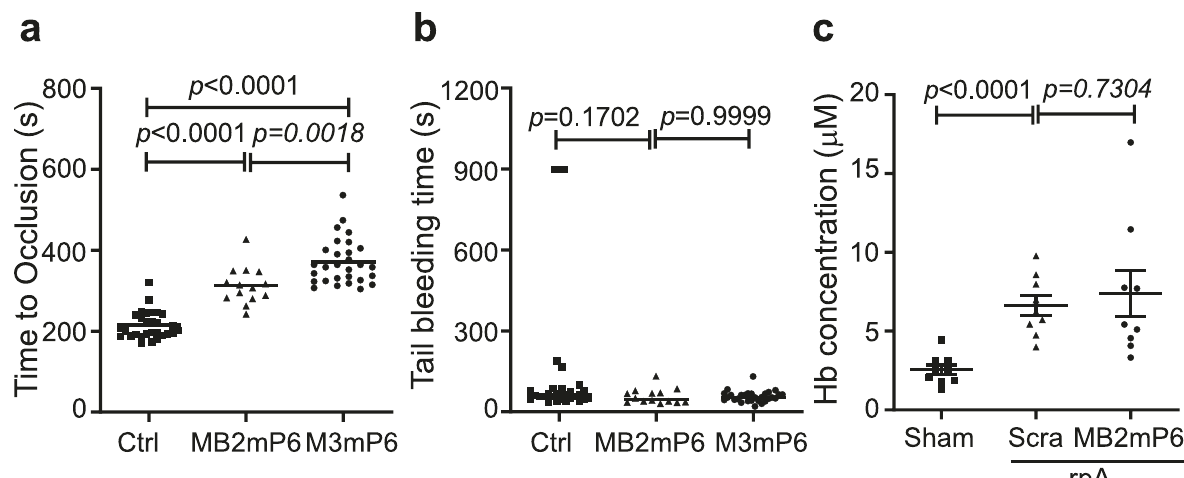
Fig. 4 The effects of MB2mP6 on FeCl 3 -induced carotid artery thrombosis and on hemorrhage in vivo. a , b Comparison of the effects of MB2mP6 and M3mP6 (Myr-FEEERL) on FeCl 3 -induced carotid artery thrombosis ( a ) and tail-bleeding time ( b ) (control, n = 29; MB2mP6, n = 14; M3mP6, n = 29, independent animals). c Comparison between MB2mP6 and scrambled peptide on in fl ammation-induced hemorrhage in the rpA assay ( n = 9 for all groups, independent animals). All data are shown as mean ± SEM. Data in ( a ), ( b ) and ( c ) were analyzed by unpaired Mann – Whitney test